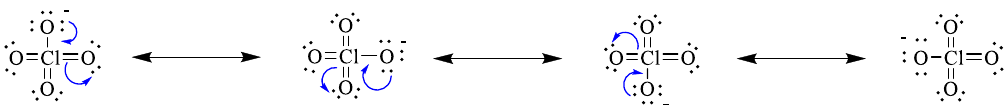
Figure 7. Resonance structures of perchlorate (ClO 4- ) connected by arrows indicating mesomerism. The hooked arrows point towards “delocalized” electron pairs which are “moving” in the representation to generate four distinct structures. In contrast, this “movement” cannot be observed experimentally, as there is only one perchlorate molecule. The hooked arrows serve solely the purpose of explanation and to connect the four resonance structures required to describe perchlorate, its properties, acidity of perchloric acid, spectroscopy and reactivity fully.